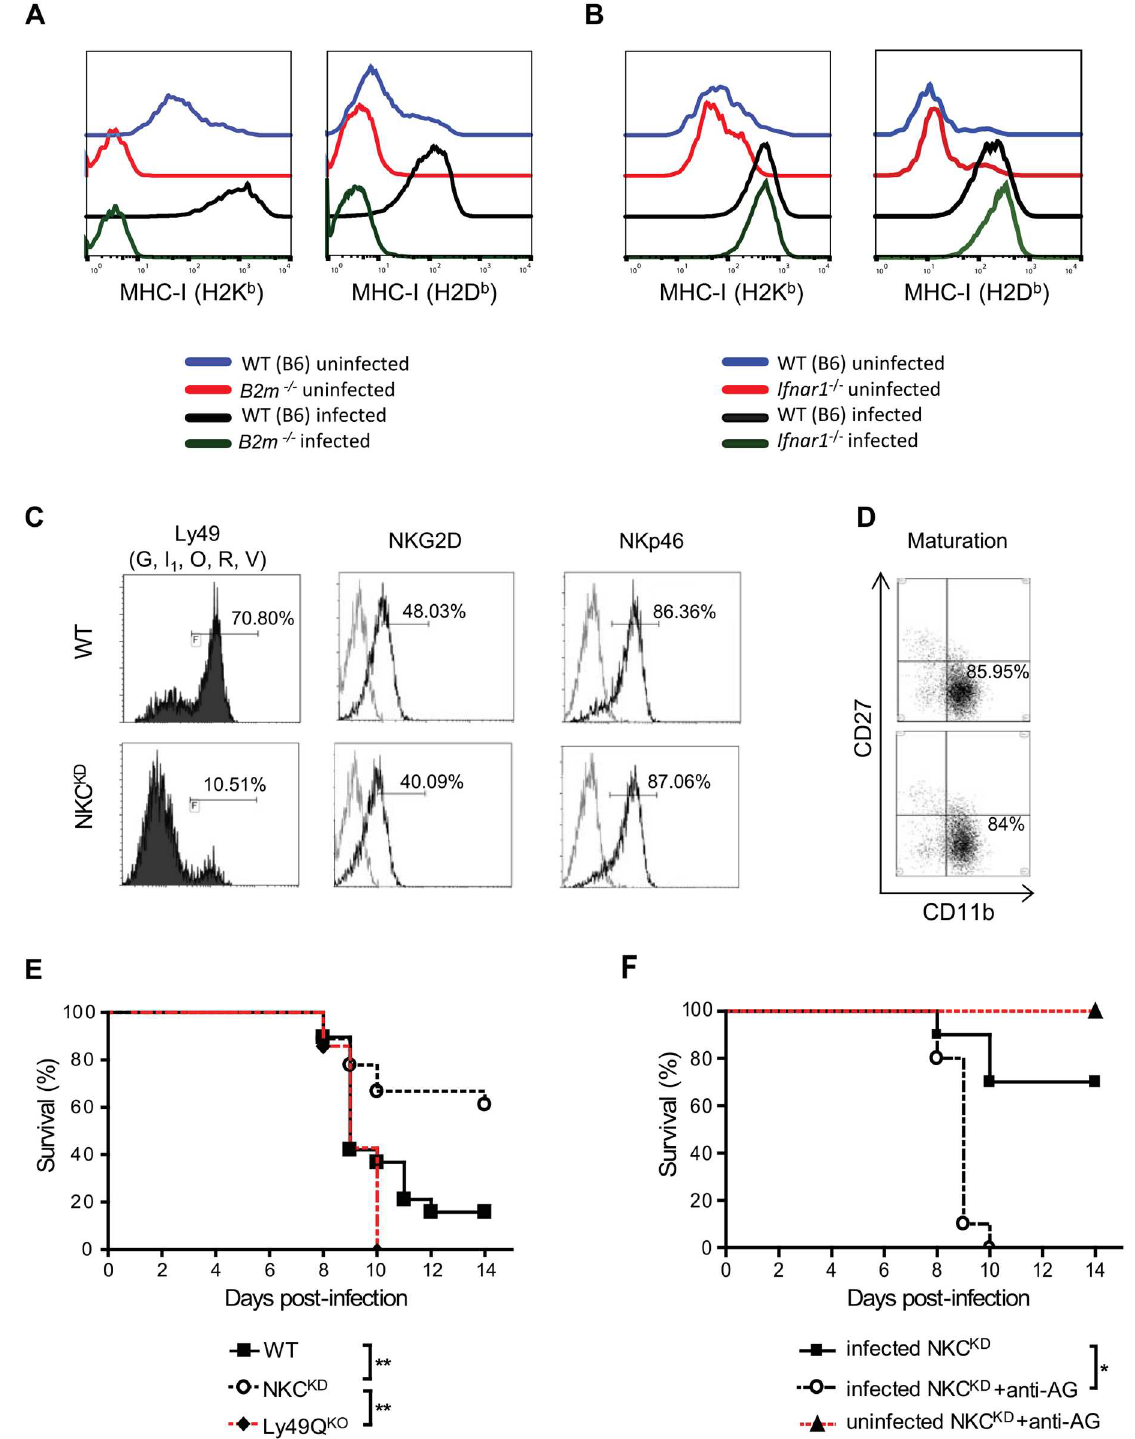
Fig 1. Ly49-deficient mice are protected from lethal influenza infection. (A, B) Groups of sex-matched WT (B6), Ifnar1-/- and B2m-/- mice were infected intranasally with 600 PFU of FM-MA virus. Single-cellsuspensions were preparedfrom uninfectedlungs and those infected with the virus for 5 days. Cells were stainedwith antibodiesagainstH-2Kb or H-2Db and CD326 (EpCAM—epithelialcell marker), and analyzedby flow cytometry. Surface expressionof H-2Kb or H-2Db was determined on EpCAM+ lung epithelial cells. The followingmAb were used in this experiment: anti-LFA-1, anti-EpCAM, anti-H-